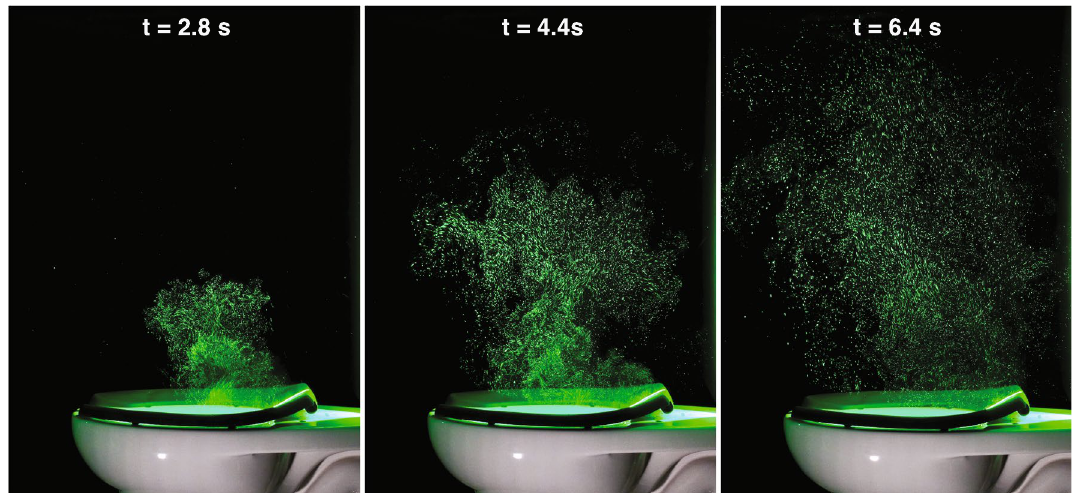
Figure 2. Photographs of the illuminated aerosol plume at t = 2.8, 4.4, and 6.4 s (indicated with dotted lines in Fig. 1D) after flush initiation. For these images and for Movie S1, we used a continuous wave laser and a commercial color camera; the images show the illuminated plume as it appears to the human eye in the laboratory.